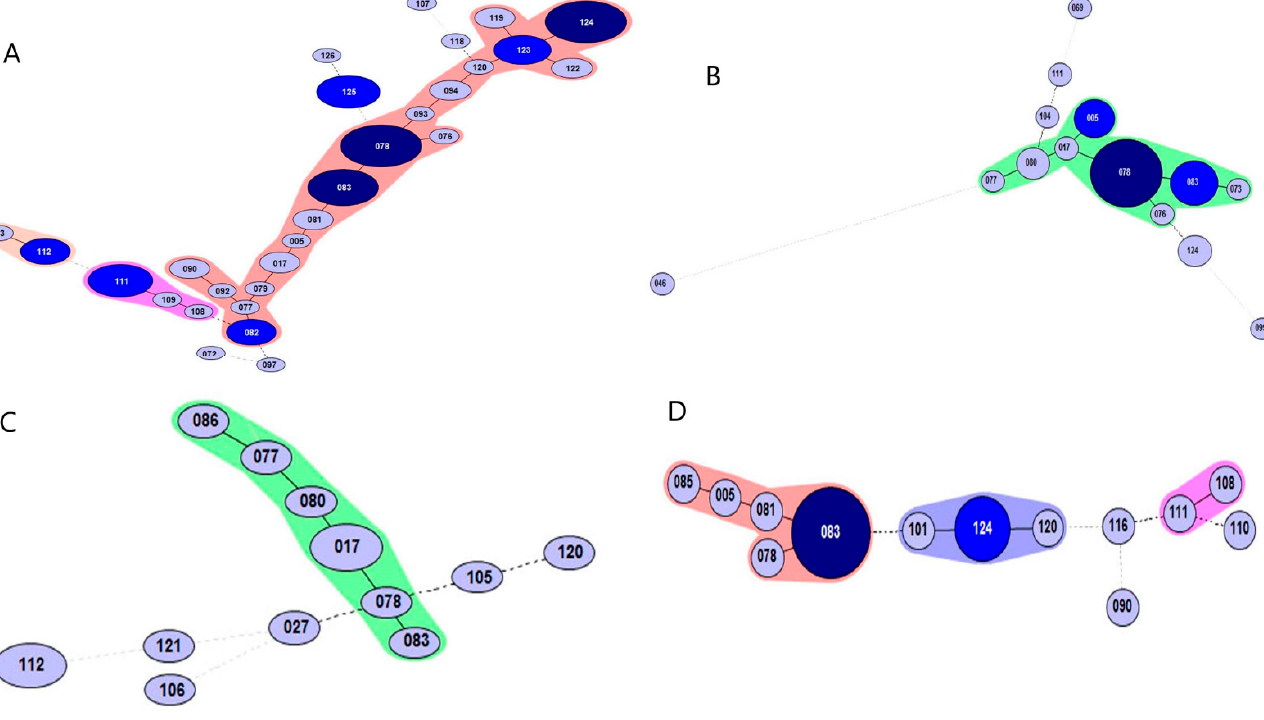
Figure 3. Minimum spanning tree analysis of Clostridioides difficile polymerase chain reaction ribotype 017 isolates typed by multilocus variable-number tandem-repeat analysis (MLVA) according to admitted hospital department. Each circle represents a unique MLVA type. ( A ) Pulmonology 66 isolates; ( B ) Nephrology 30 isolates; ( C ) Hemato-oncology 15 isolates; ( D ) Neurosurgery 20